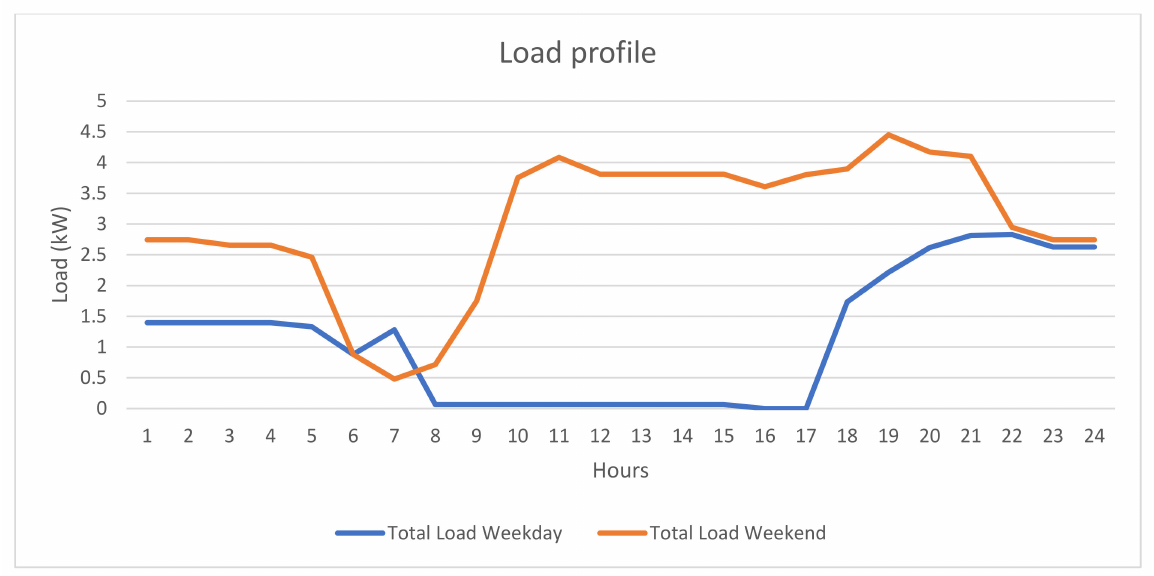
Figure 6. Load profile for a weekday and weekend day of a typical desert